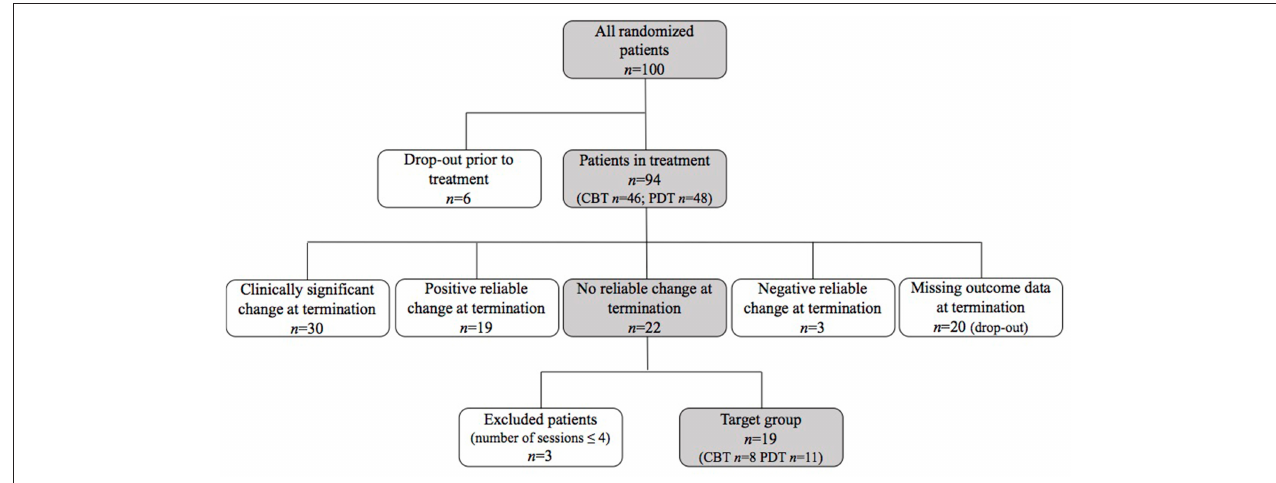
FIGURE 1 | Flow chart of sample